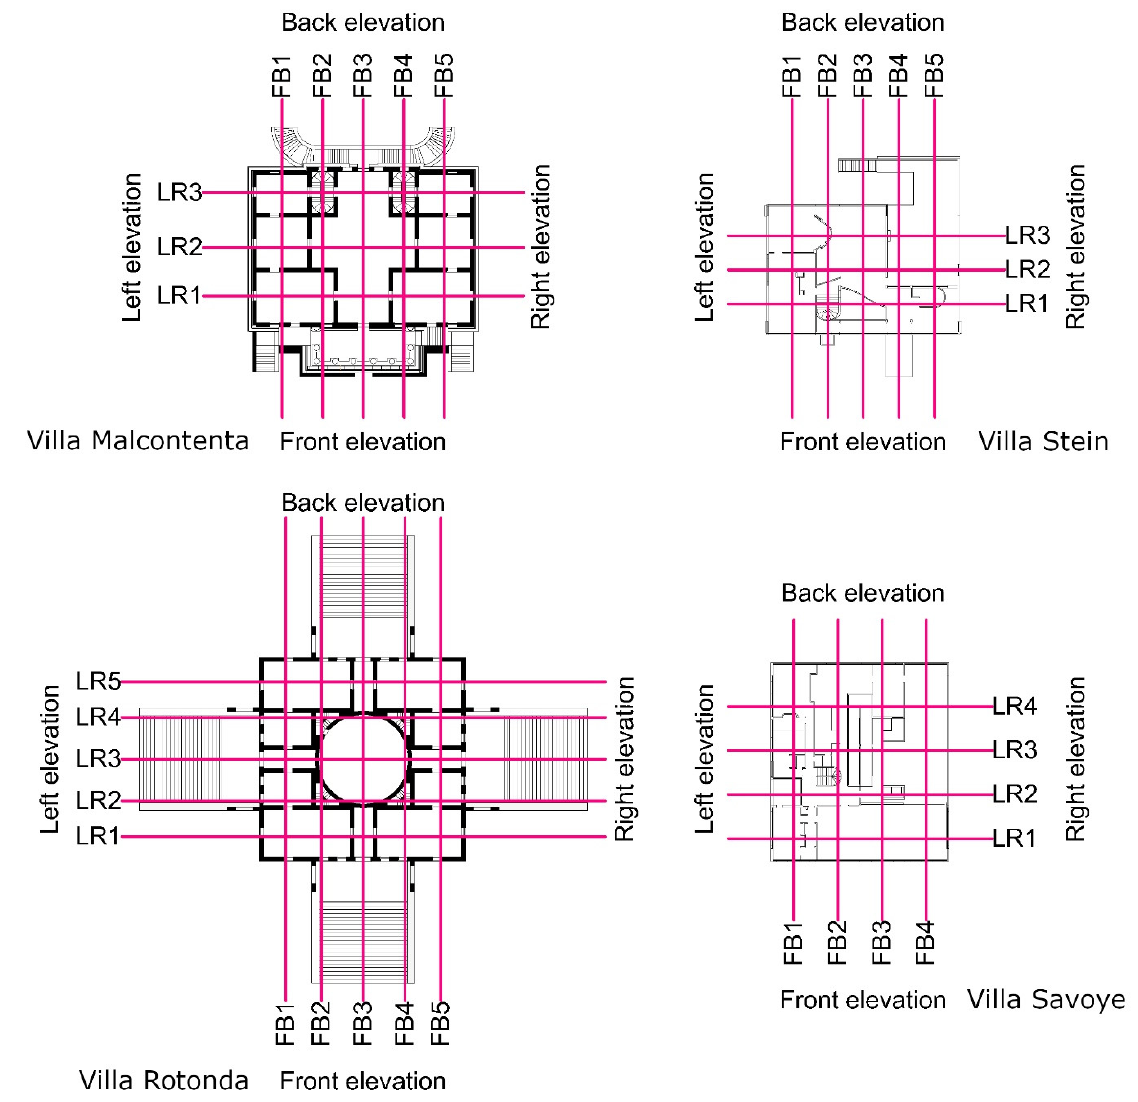
Figure 6. Location map for cross section planes through each villa.